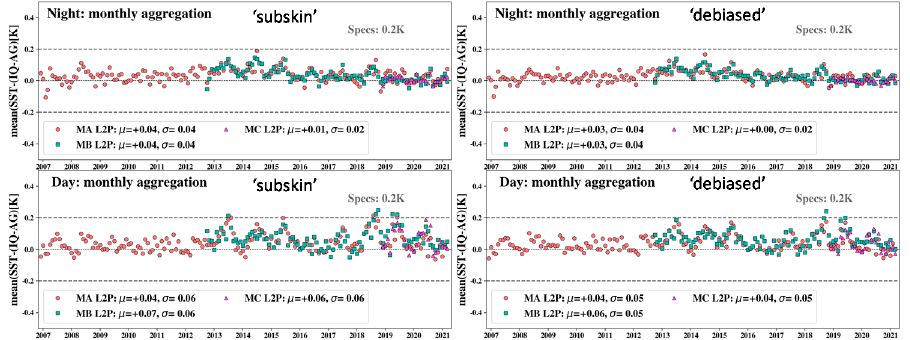
Figure 12. Time series of monthly ACSPO—AF SST global mean biases. ( Top ) night; ( bottom ) day; ( left ) GR; ( right ) PWR.